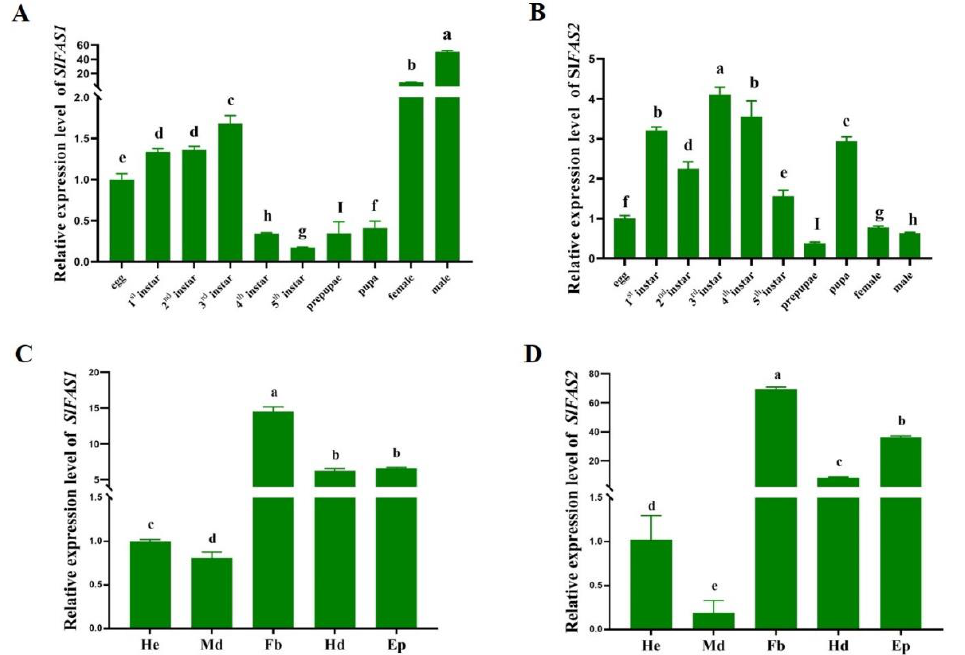
Figure 3. Expression of SlFAS1 and SlFAS2 in different development stages and tissues. ( A ) Expression patterns of SlFAS1 in different development stages. ( B ) Expression patterns of SlFAS2 in different development stages. ( C ) Expression patterns of SlFAS1 in different tissues. ( D ) Expression patterns of SlFAS2 in different tissues. He, haemolymph; Md, midgut; Fb, fat body; Hd, head; Ep, epidermis. Significant differences in expression levels among developmental stages and different tissues were compared using a one-way analysis of variance (ANOVA) with Tukey’s post-hoc test. Different lowercase letters above the bars indicate significant differences ( p < 0.05).